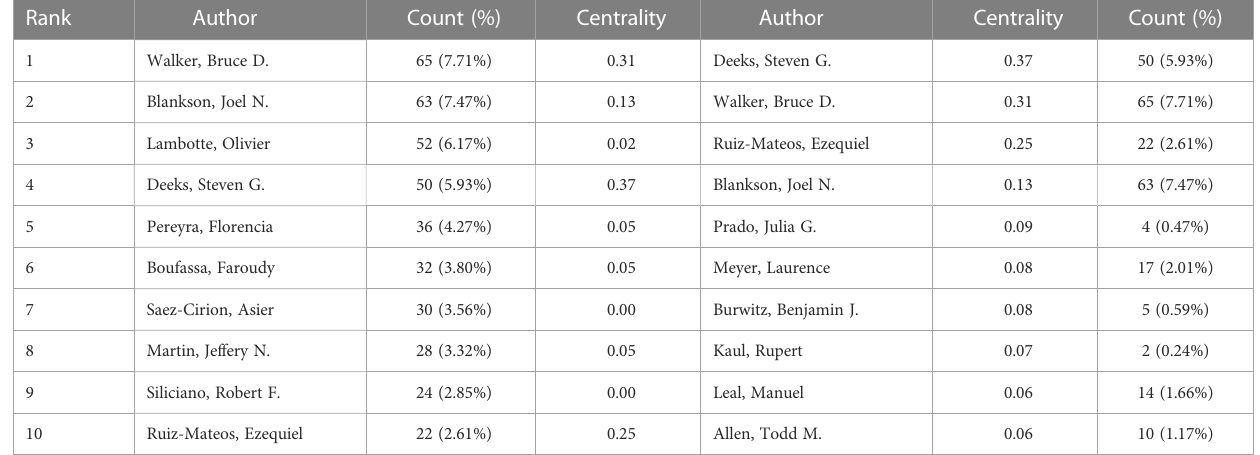
TABLE 3 The top ten authors with the most publications (left sides) and betweenness centrality (right sides).